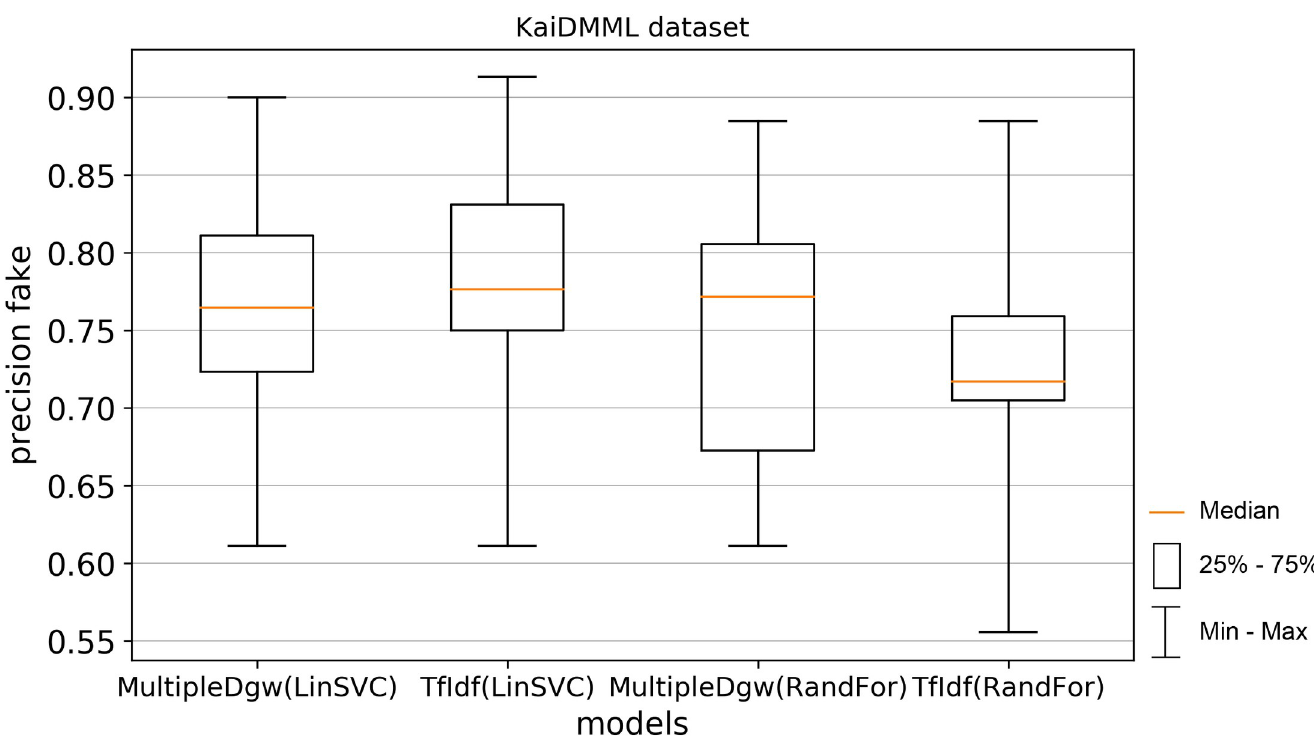
Fig 7. Boxplot for the model performance measurement—precision_fake for dataset KaiDMML.